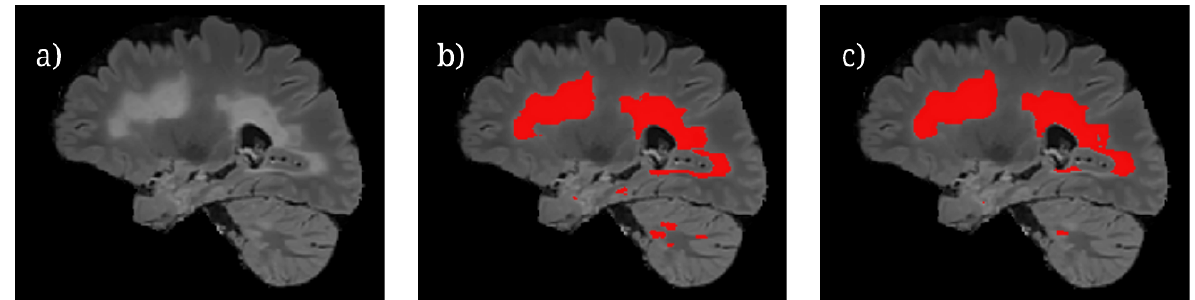
Figure 6. Segmentation results for U-Net++ with ResNeXt-50 when using FLAIR: ( a ) sagittal FLAIR slice, ( b ) overlayed ground truth lesions (red), and ( c ) overlayed model predictions (red).